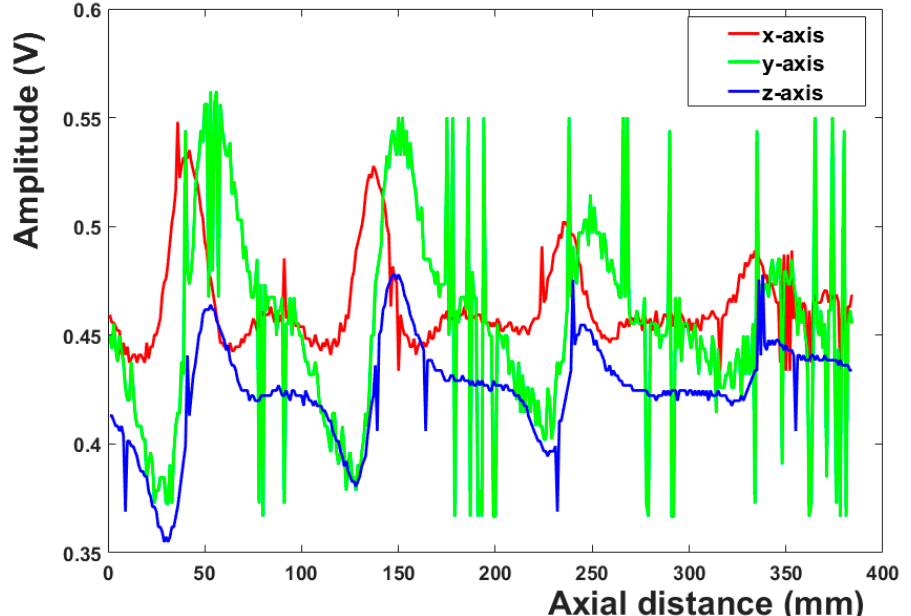
Figure 5. 3D magnetic leakage before noise reduction in channel 8. The SWT Denoising1D module of MATLAB [24] software is used for noise reduction. Sym function is selected as the wavelet basis function in MATLAB. Sym has good regularity and symmetry, which makes the signal reconstruction process relatively smooth and can, to some extent, reduce phase distortion in the signal analysis and reconstruction